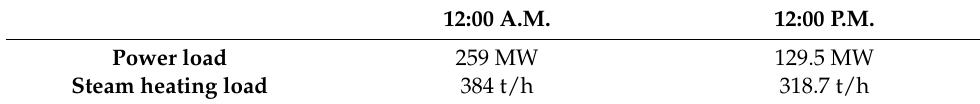
Table 5. Heat load and power load of the coupling system.